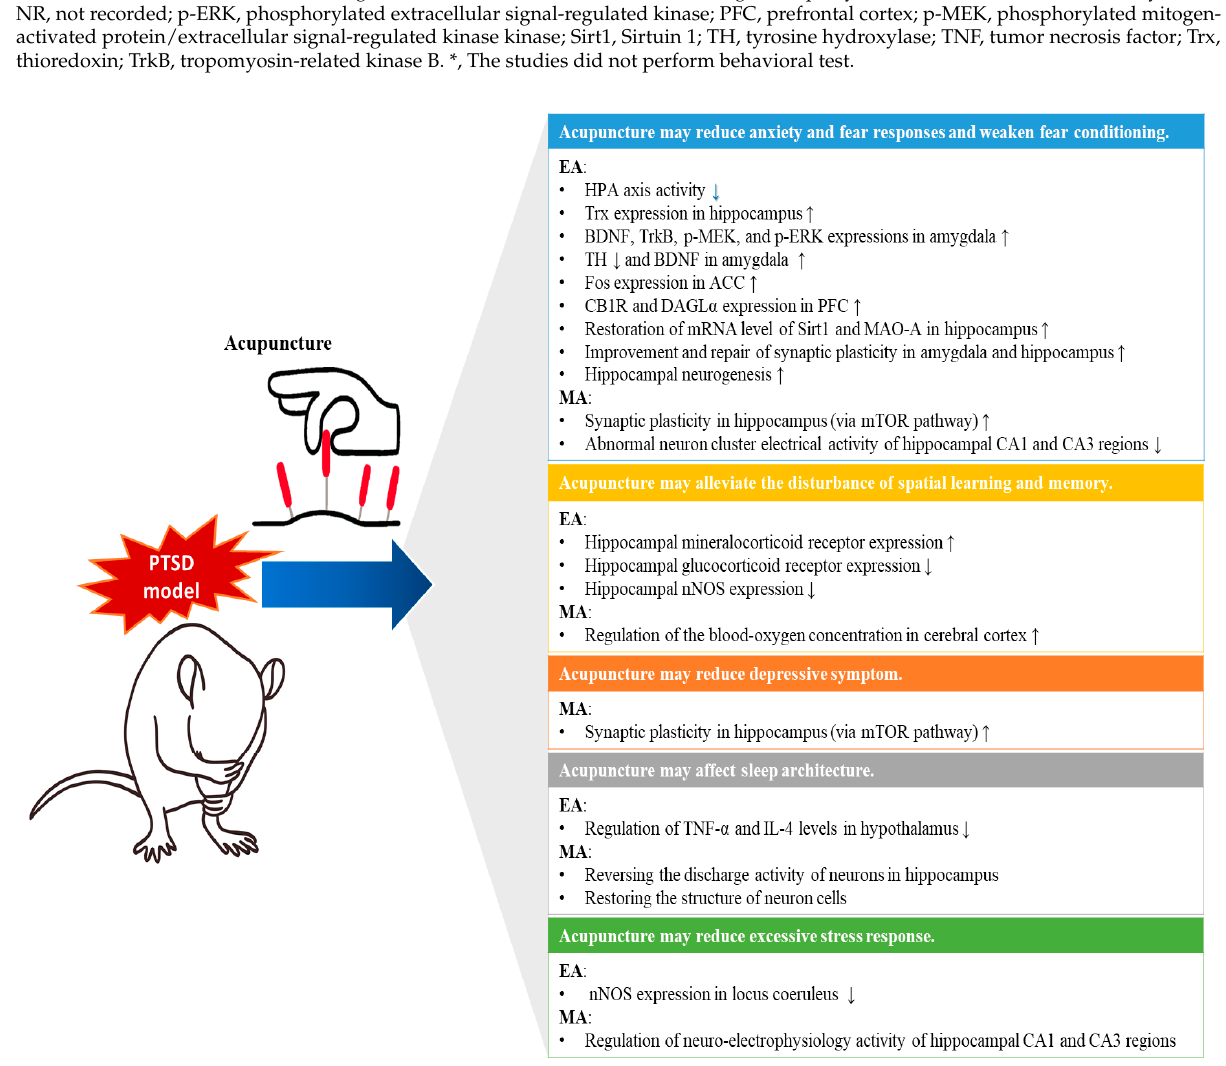
Table 2. Target symptoms and proposed mechanisms. Study